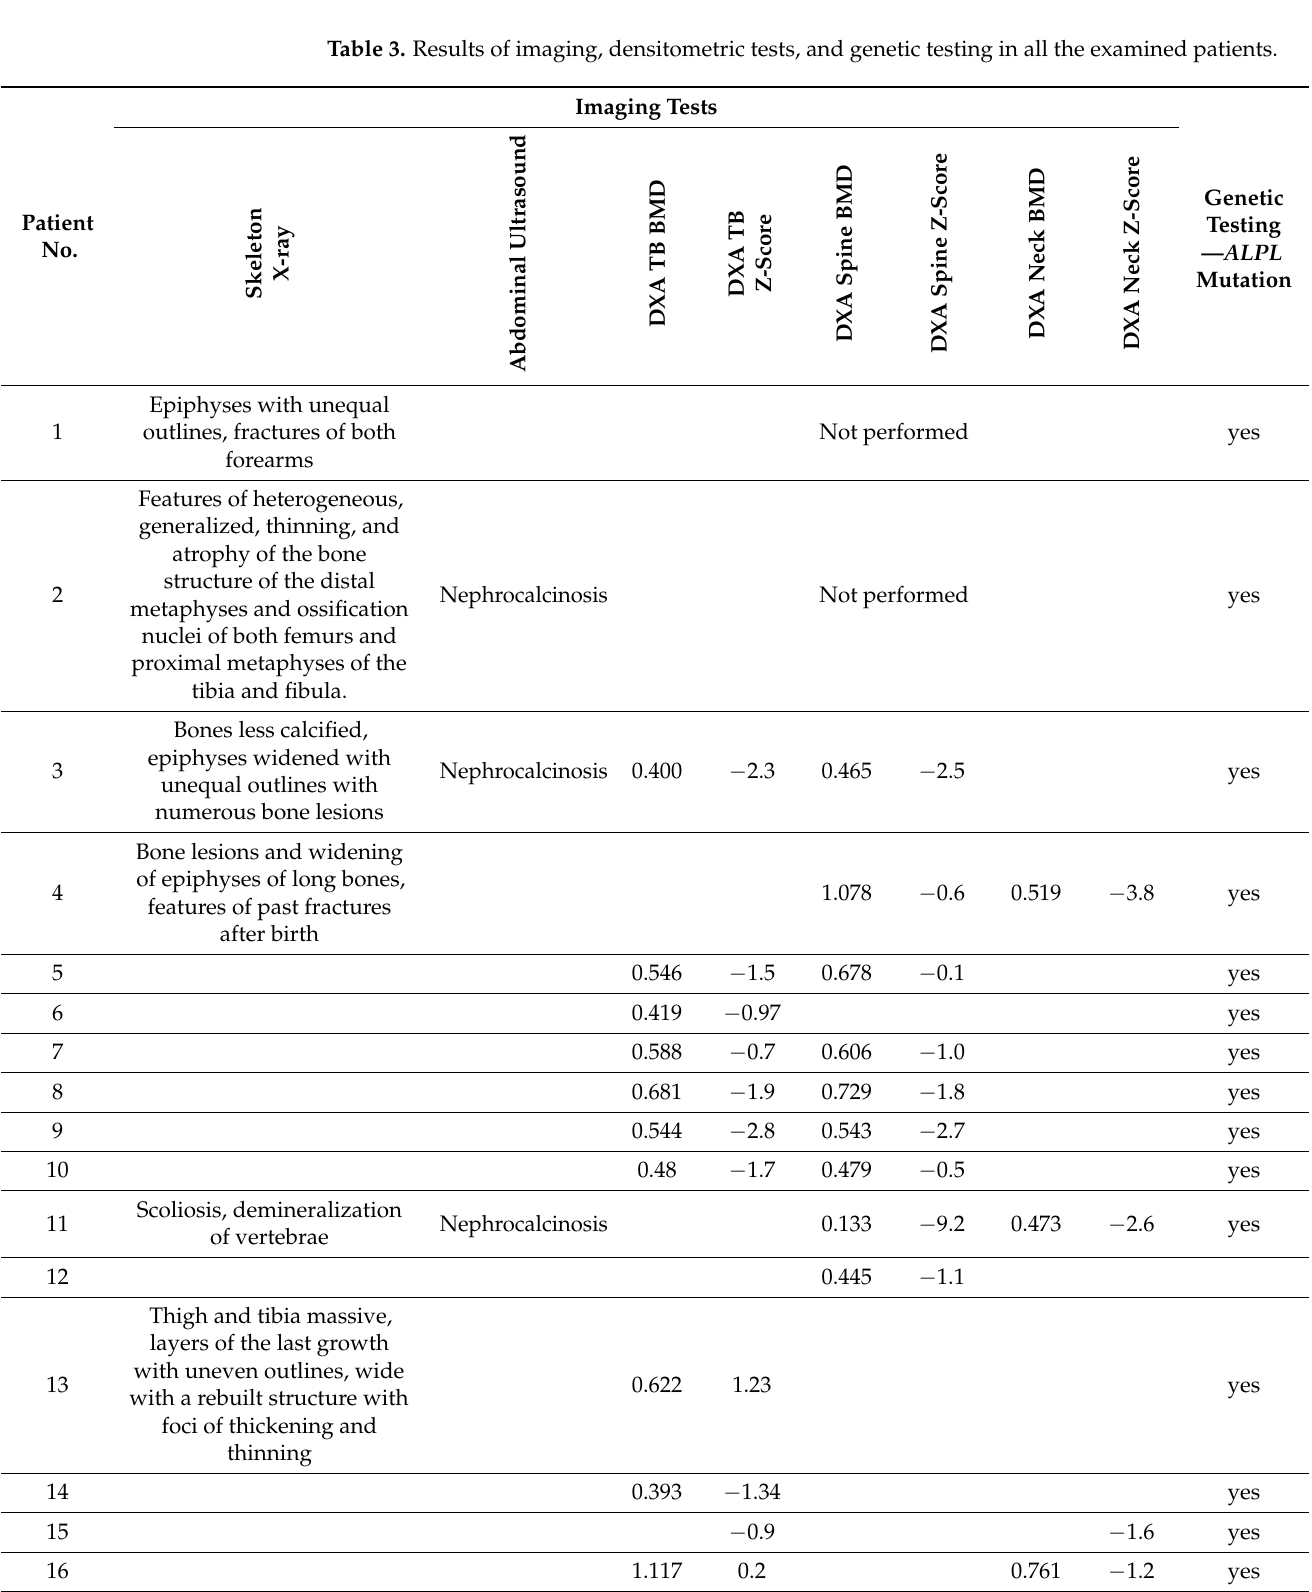
Table 3. Results of imaging, densitometric tests, and genetic testing in all the examined